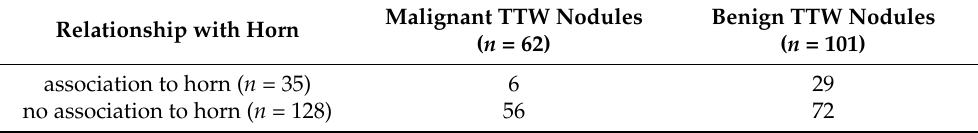
Table 4. Association between location and malignancy rate of TTW nodules. Malignant TTW Nodules Benign TTW Nodules Location ( n = 62) ( n = 101) dorsal position ( n = 78) 22 56 non-dorsal position ( n = 85) 40 45 p = 0.019. Table 5. Relation between association to a horn and malignancy rate of TTW nodules. Malignant TTW Nodules Benign TTW Nodules Relationship with Horn ( n = 62) ( n = 101) association to horn ( n = 35) 6 29 no association to horn ( n = 128) 56 72 p = 0.003.